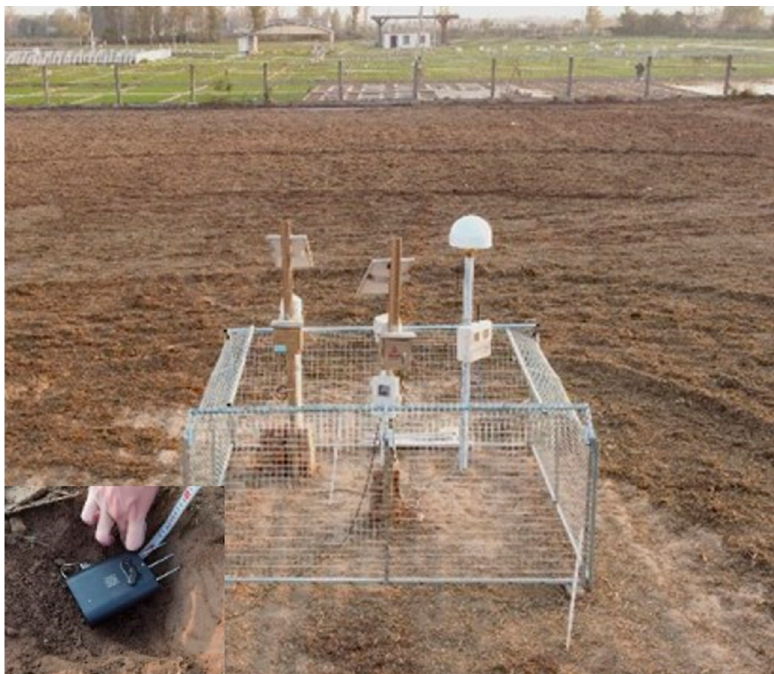
Figure 5. Surrounding environment and experimental equipment.